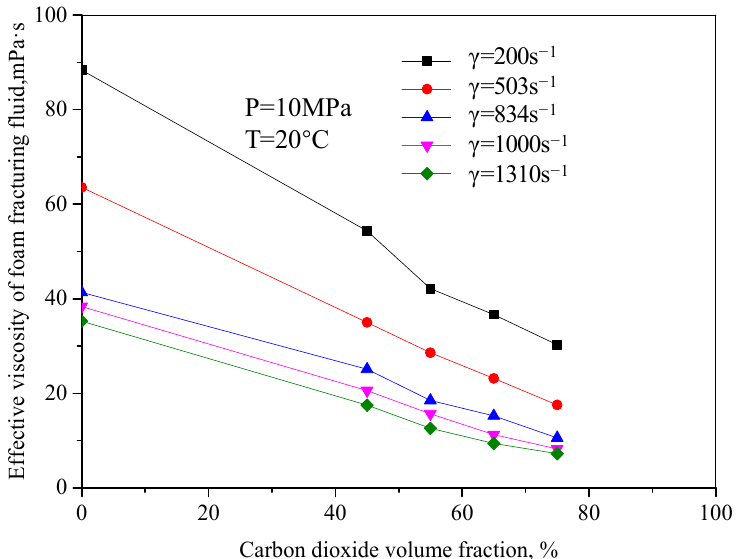
Figure 3. The curve of effective viscosity changes with CO 2 volume fraction (Unfoamed, T = 20 °C). Figure 4 is the variation law curve of the effective viscosity of CO 2 foam gel